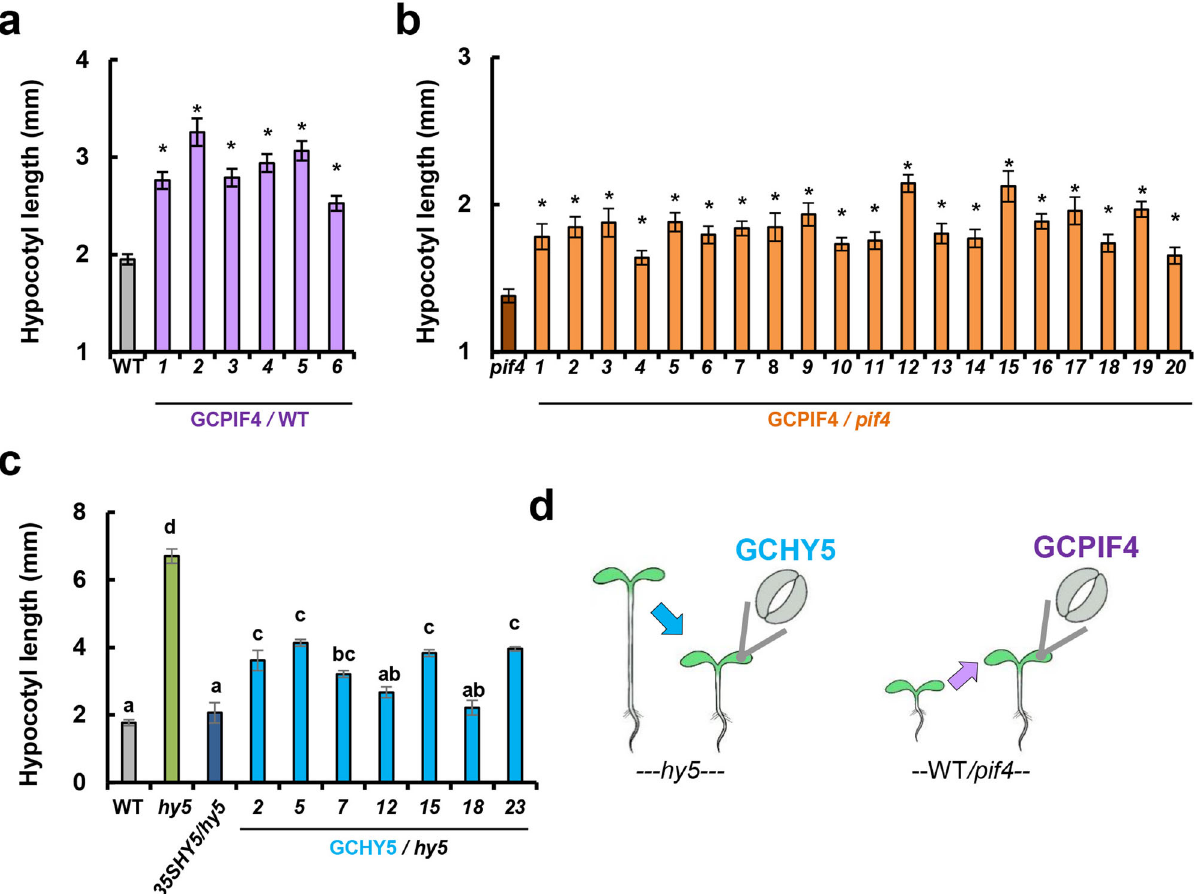
Fig. 5 Expression of PIF4 (GCPIF4) and HY5 (GCHY5) in guard cells affects hypocotyl elongation. a GCPIF4 in the WT background (purple columns) stimulates hypocotyl elongation of independent GCPIF4/WT lines relative to the WT. b GCPIF4 in the pif4 -mutant background (orange columns) stimulates hypocotyl elongation of independent GCPIF4/ pif4 lines. c Hypocotyl lengths of independent lines expressing HY5 in the guard cells (GCHY5/ hy5 ) or globally under the 35S promoter (35SHY5/ hy5 ) in the hy5 -mutant background (light-blue columns). Data points for ( a – c ) are means ± SE ( n = 20 – 25 for a ; n = 15 – 25 for b ; n = 13 – 25 for c ). a , b Asterisks indicate signi fi cant differences relative to the WT (Dunnett ’ s test, P < 0.05). c Different letters indicate a signi fi cant differences (Tukey ’ s HSD test, P < 0.05). d The illustration indicates the gene expressed in guard cells (GCHY5 or GCPIF4) and the genomic background ( hy5 , WT/ pif4 ). The blue and purple arrows indicate the hypocotyl-growth response stimulated by GCHY5 and GCPIF4,